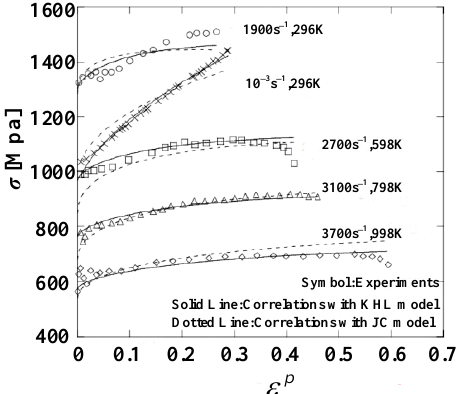
Figure 7. The modified KHL model compared with J – C model [19].